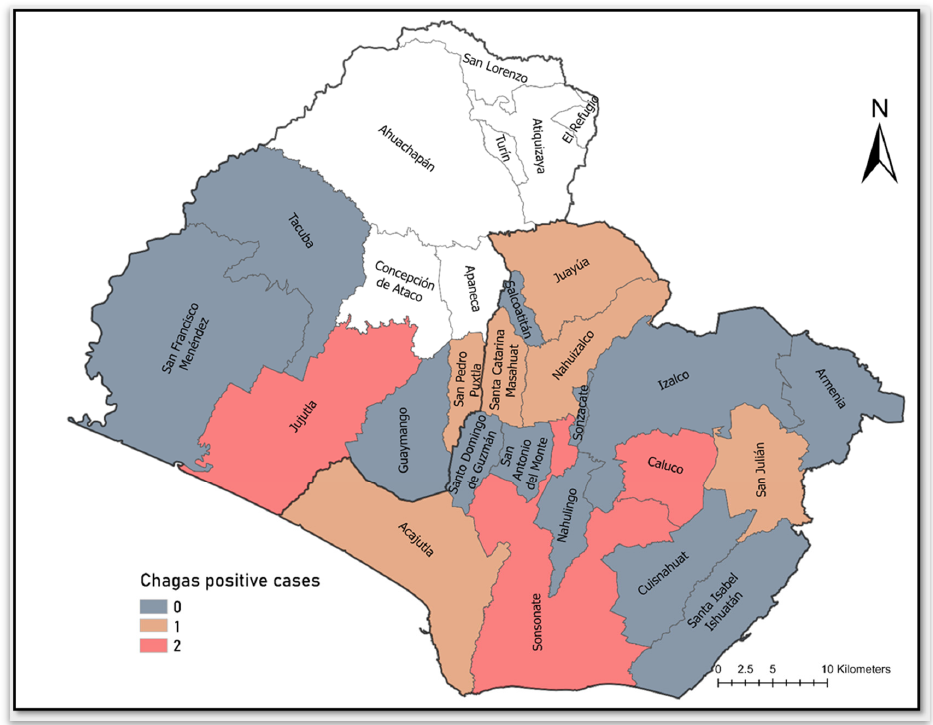
Figure 2. Map of T. cruzi -positive perinatal women from western El Salvador revealing that cases were mostly from Sonsonate department. The highest case count municipalities fell in Sonsonate and Caluco (Sonsonate department) and Jujutla (Ahuachapan department).